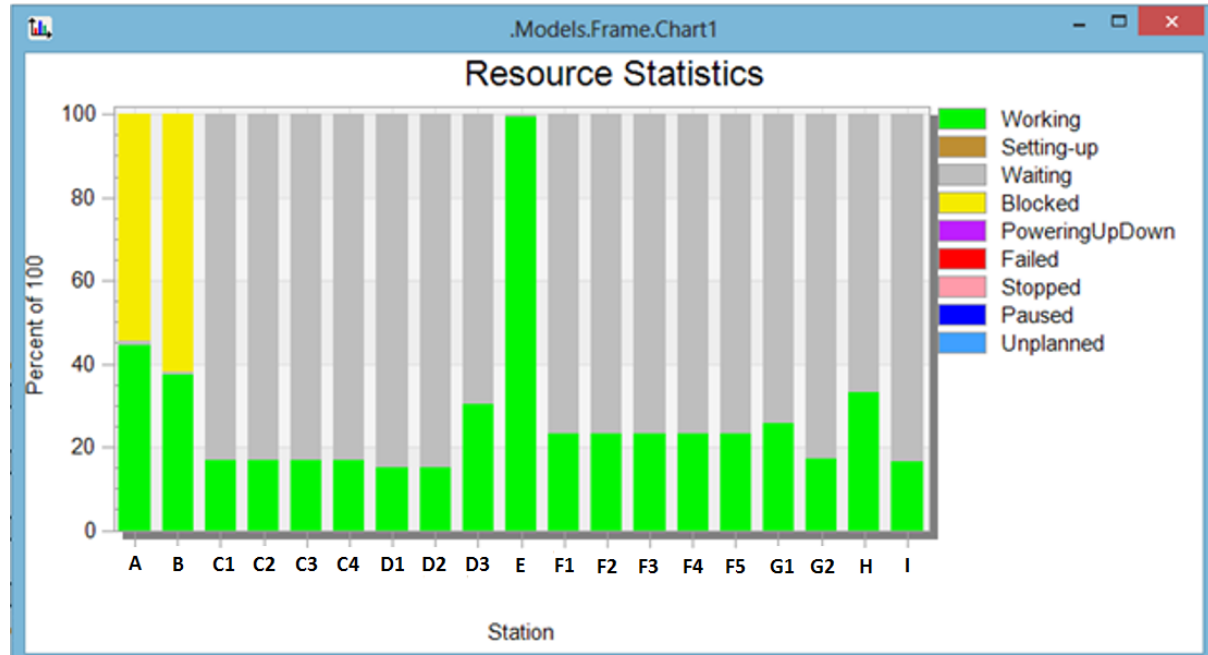
Figure 5: Capacity utilisation (time utilisation of technological operations) - existing situation.